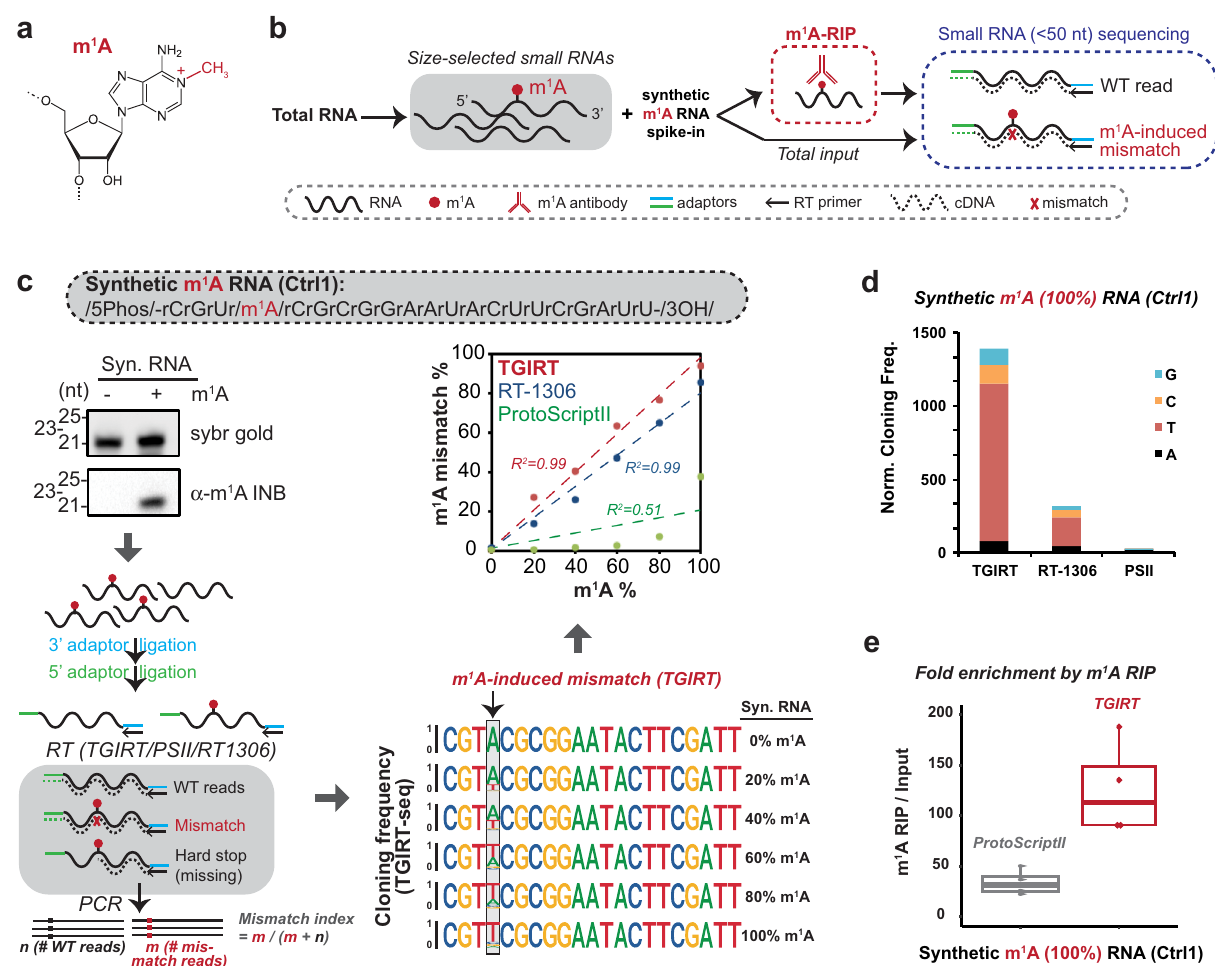
Fig. 1 Systematic mapping of m 1 A sites in small RNA space. a Chemical structure of m 1 A (N 1 -methyladenosine). b Overall m 1 A mapping strategy for small RNAs by combining m 1 A RIP and m 1 A-induced mismatch analysis. Synthetic m 1 A RNA is included as a positive control. c TGIRT identi fi ed as the optimal reverse transcriptase for m 1 A-induced mismatch analysis. Brie fl y, synthetic m 1 A-containing RNA at different m 1 A stoichiometry was sequenced by three different reverse transcriptases (RTs): TGIRT (thermostable group II intron reverse transcriptase), PSII (ProtoScriptII, retrovirus RT) and RT-1306 (engineered HIV RT). For each RT, mismatch rate was calculated across all the reads that map to the synthetic RNA sequence (allowing 1 mismatch) as represented by the sequence logo. The mismatch rate at the known m 1 A site is then plotted against known m 1 A stoichiometry ( R 2 derived from linear fi tting forced to cross intercept at zero). d ProtoScriptII leads to under-representation of m 1 A-containing RNAs. Cloning frequency is normalized to spike- ins. e m 1 A RIP successfully enriches synthetic m 1 A-containing RNA compared to input, when spiked in with total short RNAs. TGIRT captures enrichment better than ProtoScriptII. Data are based on four independent RIP experiments (two HEK293T and two U251). Boxplot center represents median, bounds represent 25 and 75%, and whiskers show the minimum or maximum no further than 1.5 * interquartile range from the bound. See also Supplementary Fig. 1 and Supplementary Table 1. Source data are provided as a Source Data fi